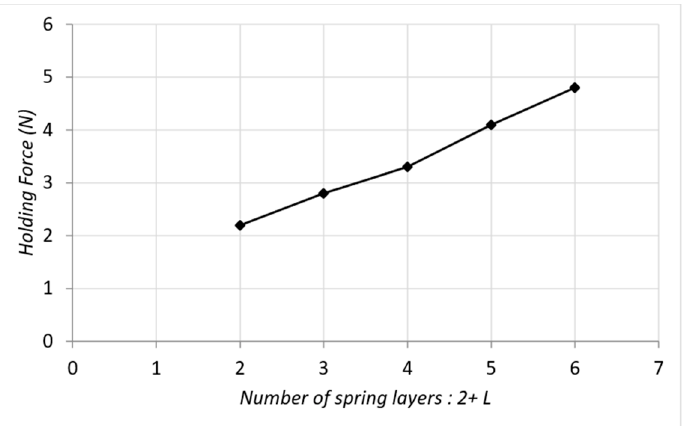
Figure 21. The slider holding force was measured for different pressing force spring configurations; the number of spring layers (L) on the back of the stator was 2, 3, 4, 5 or